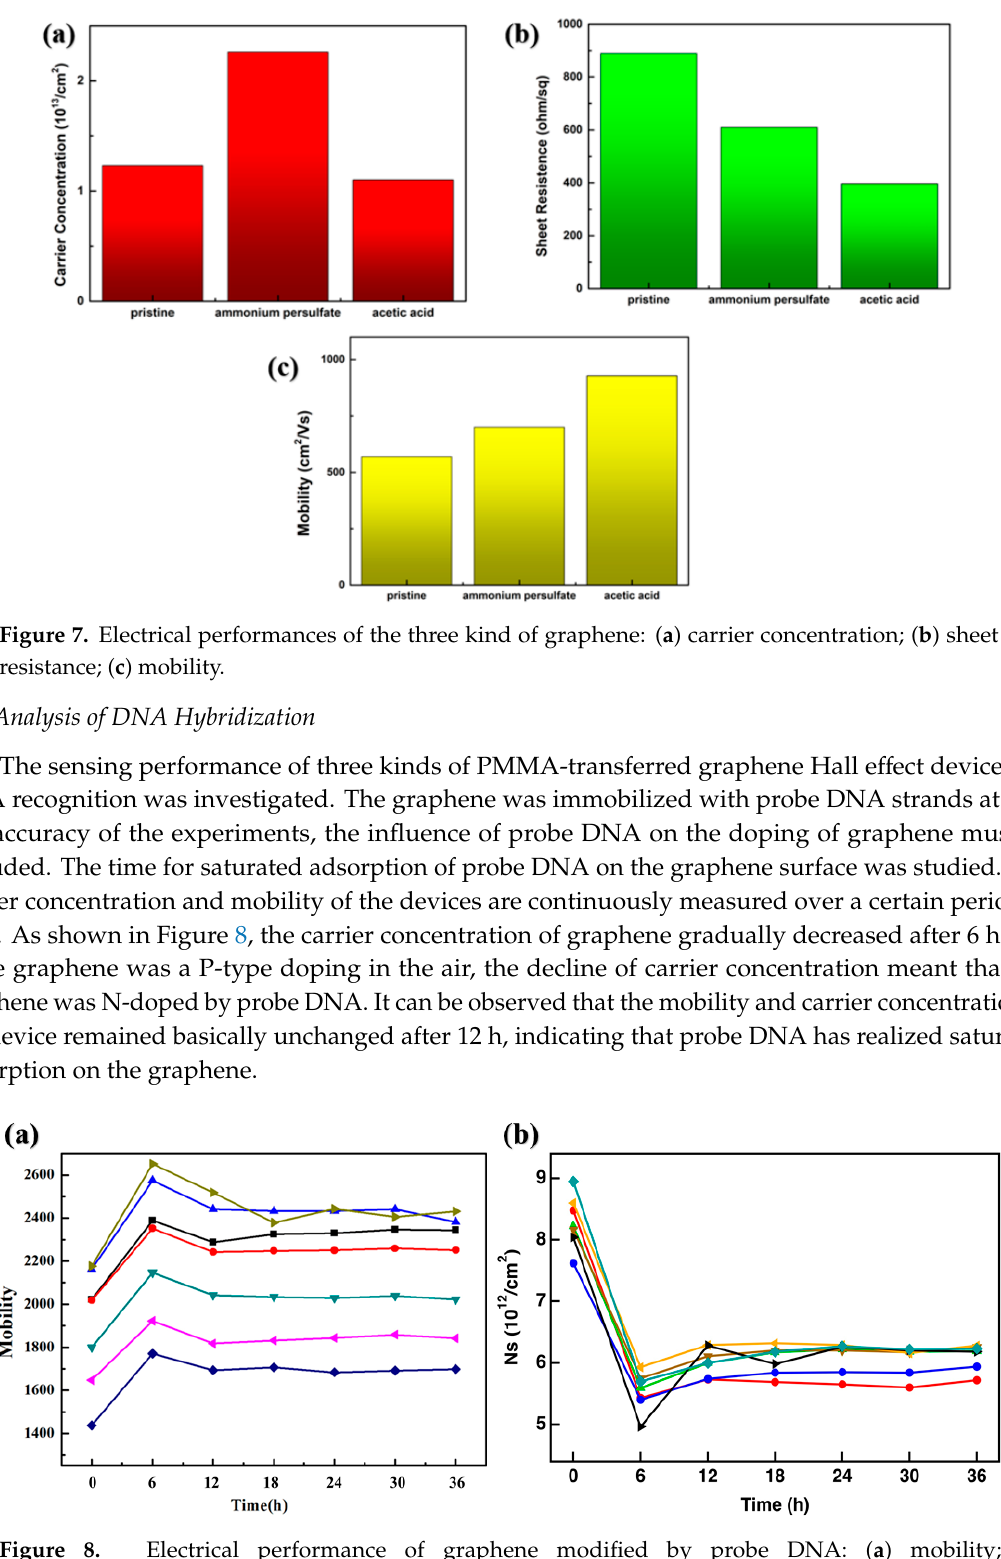
Figure 8. Electrical performance of graphene modified by probe DNA: ( a ) mobility; ( b ) carrier concentration.